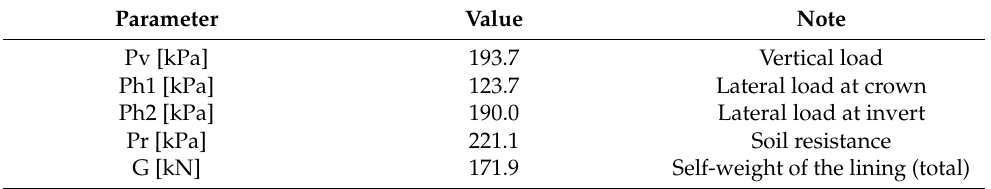
Figure 3. The exemplary assembly and load distribution of the segmental tunnel ring. Table 1. The parameters of external load. Table 1. The parameters of external